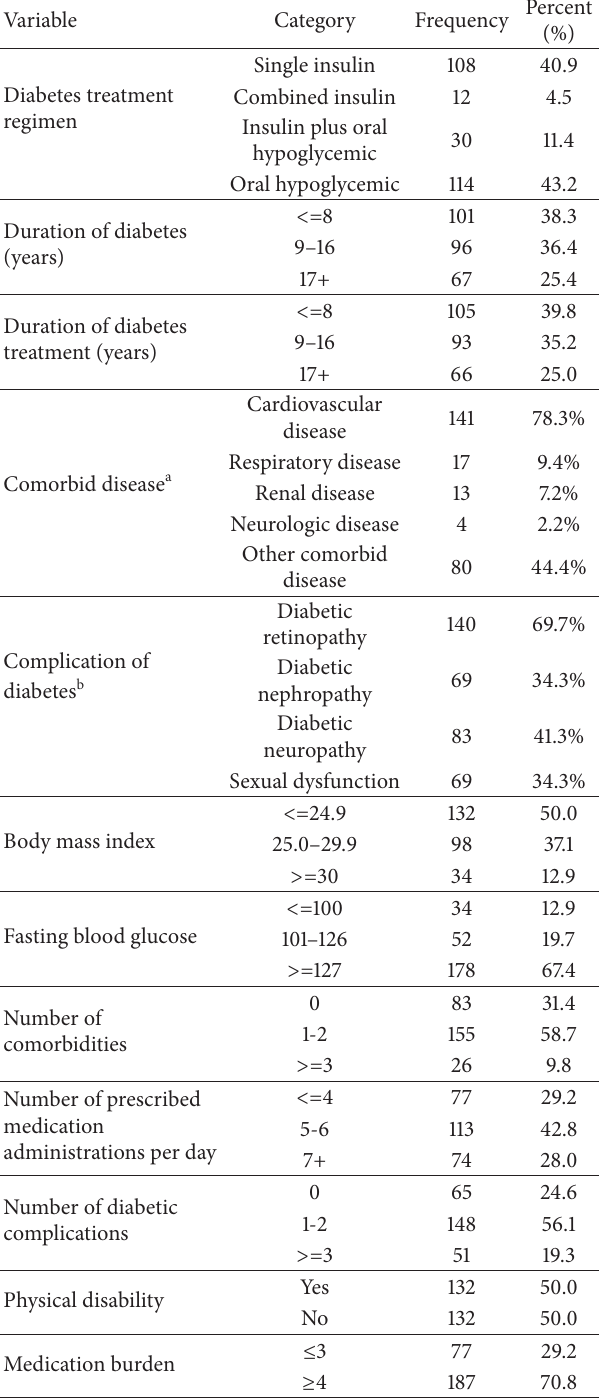
Table 2: Clinical characteristics of type 2 diabetic outpatients in Black Lion General Specialized Hospital, Addis Ababa, Ethiopia, 2013. ( 𝑛 = 264 ).